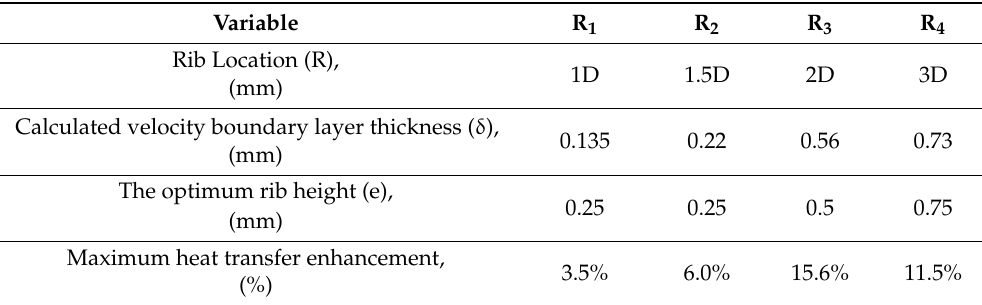
Table 3. Summary of findings.